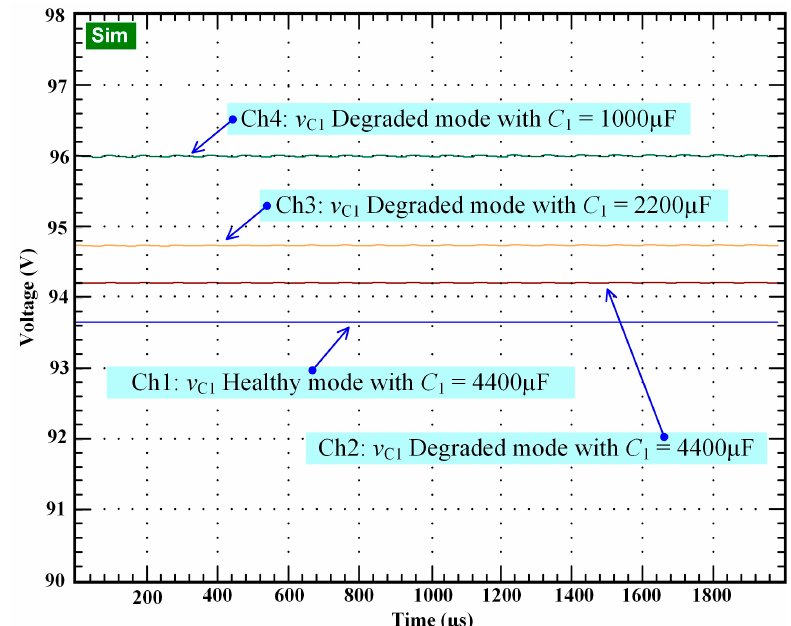
Figure 20. Voltage across C 1 terminals before and after fault, calculated with different values of the capacitance.